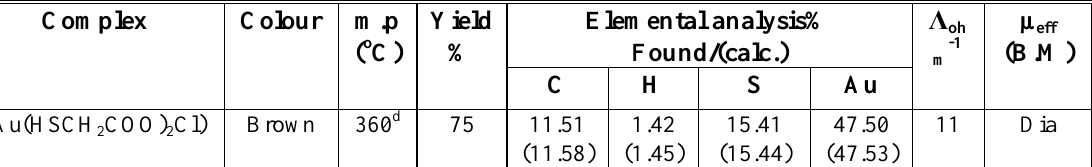
Table( 1) : Physical Properties of the complex Complex